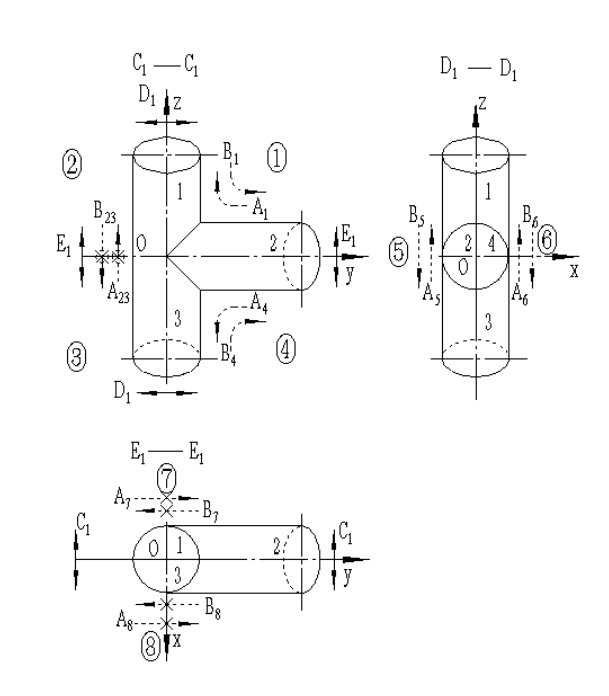
Fig. 12 Motion planning for T